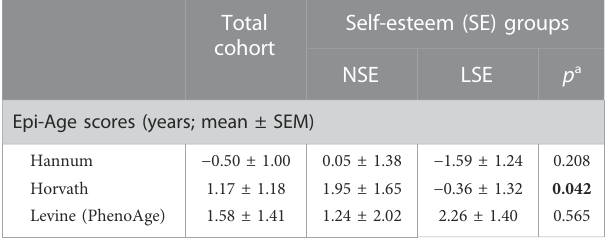
TABLE 5 Mean epigenetic age (Epi-Age) acceleration per SE group. Epi-Age values are represented here as the difference between mean Epi-Age and mean chronological age. Positive scores suggest age acceleration, while negative scores suggest age deceleration.